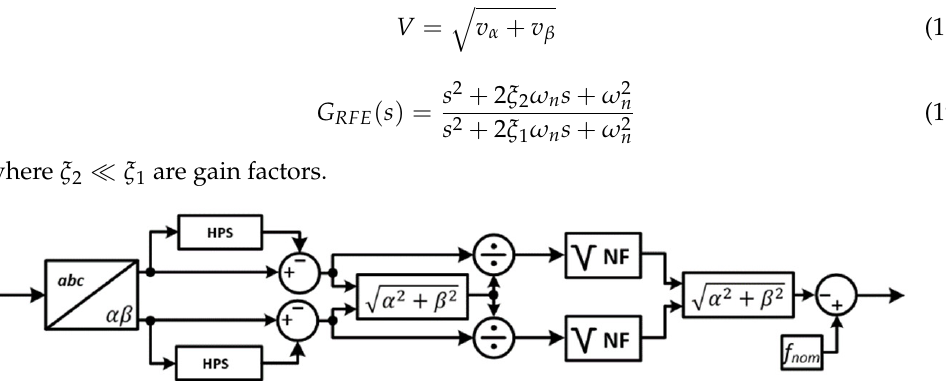
Figure 6. Resonant frequency estimator algorithm, where HPS—high pass filter and NF—notch